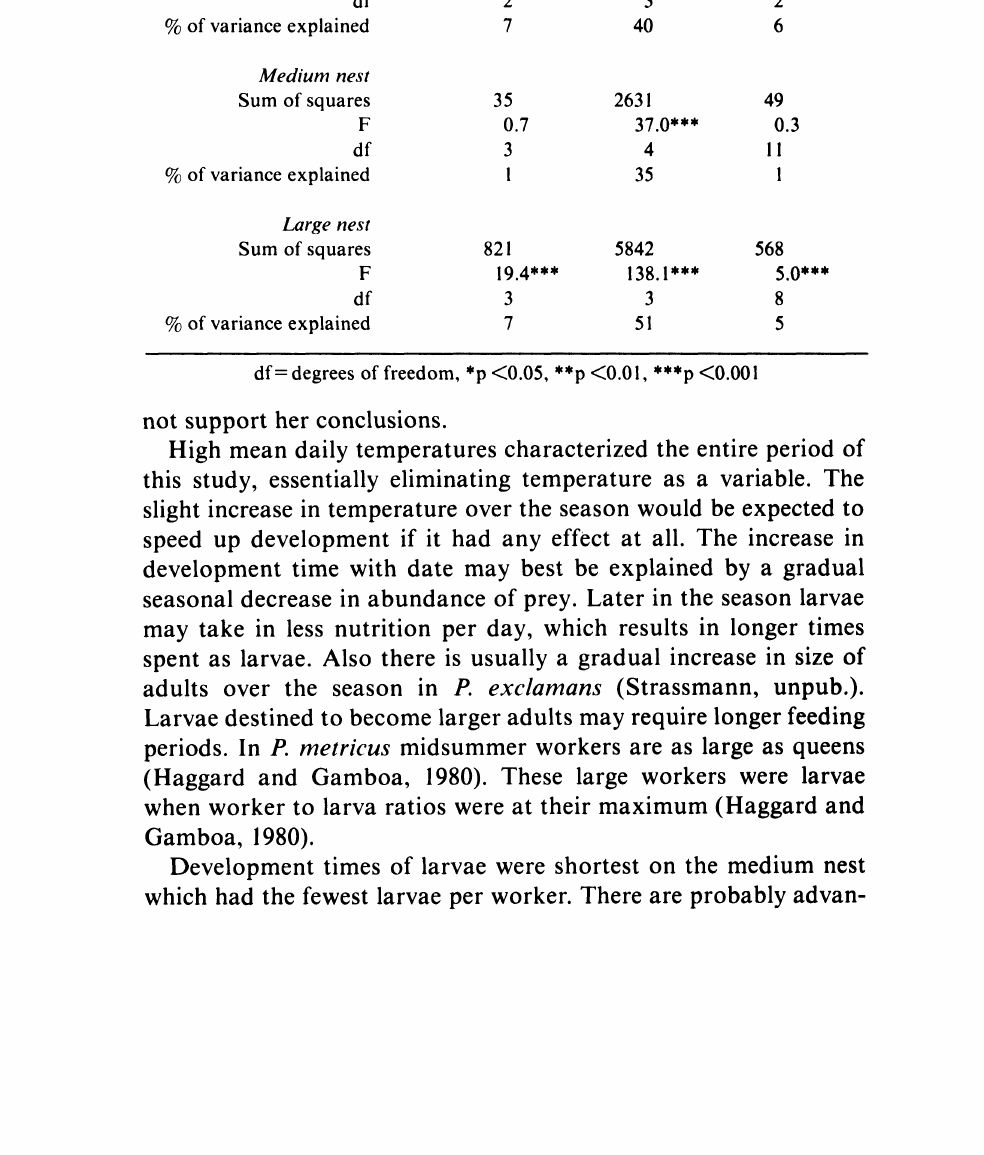
TABLE 3. ANOVA of the effects of date and location in nest on larva development